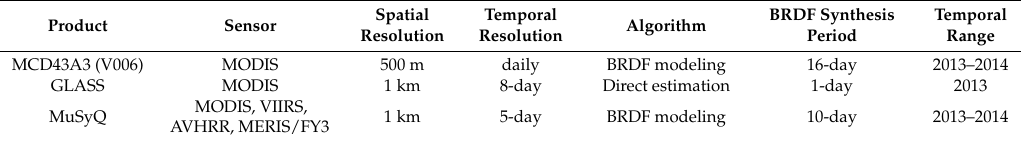
Table 2. List of coarse-scale albedo products in this paper.